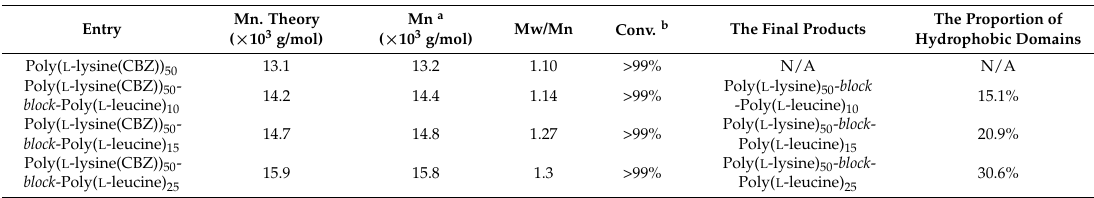
Table 1. Results of polymerization.